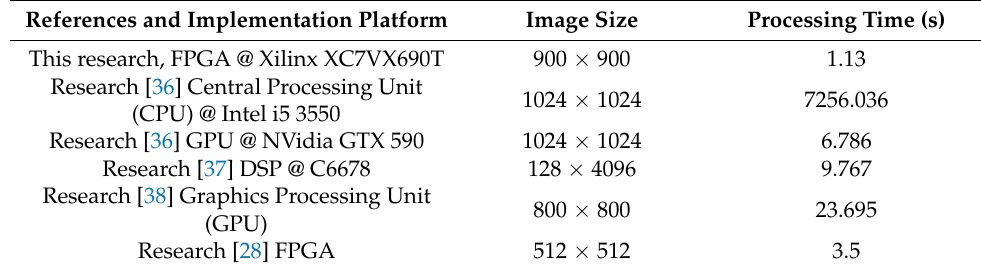
Table 4. Comparison of processing time consumption.